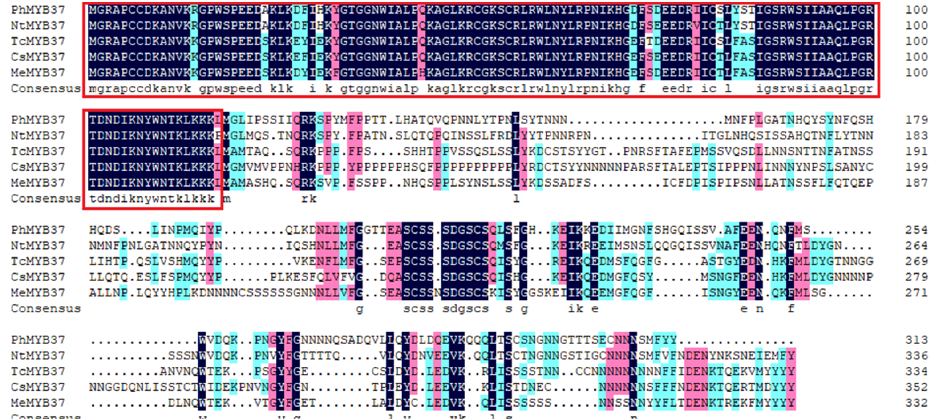
Figure 3. Protein sequence alignment of PhMYB37, NtMYB37, TcMYB37, CsMYB37, and MeMYB37.